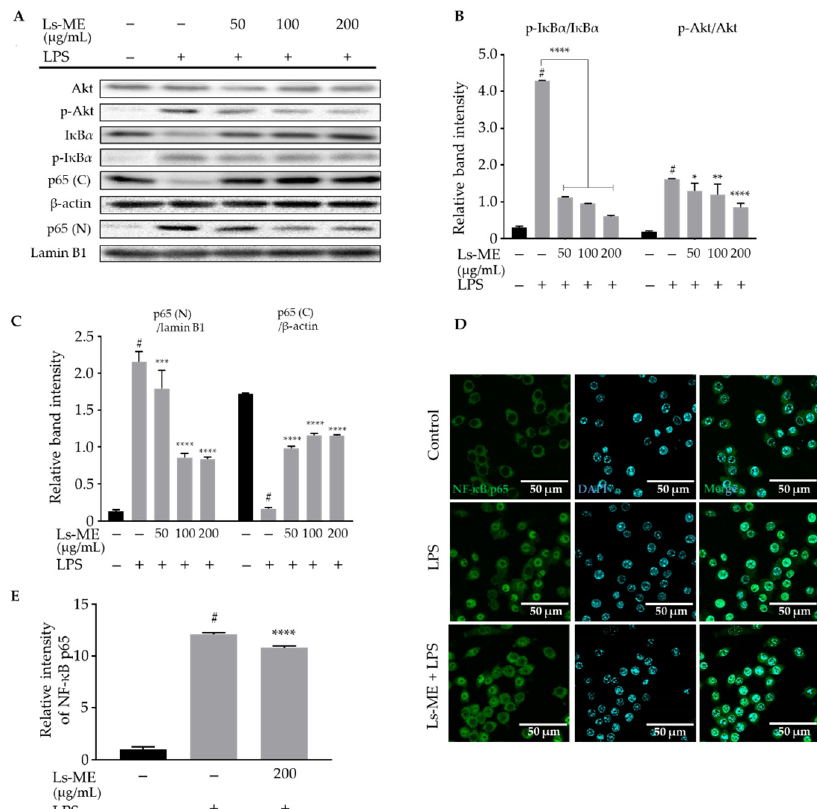
Figure 4. The inhibitory activity of Ls-ME on the activation of NF- κ B / PI3K / Akt pathways in LPS-stimulated RAW 264.7 macrophages. Cells were cultured with serial concentrations of Ls-ME for 24 h, followed by treatment with LPS (1 µ g / mL) for 18 h. Western blot analysis determined the expression of total Akt, I κ B α and phosphorylated p-Akt, p-IkB α ( A ). Cytosol and nuclear fractions were separated in whole-cell lysates to analyze p65 (C, cytosol) and p65 (N, nucleus). The relative band intensity of p-I κ B α to I κ B α and that of p-Akt to Akt was quantified ( B ). The relative band intensity of p65 (C, cytosol) and p65 (N, nucleus) was quantified ( C ). The relative band intensities were analyzed using Image J. Representative images are shown in ( D ) with the green color of Alexa-488. Control, cells incubated alone; LPS, cells incubated with LPS; Ls-ME + LPS, cells incubated with Ls-ME (200 µ g / mL), then treated with LPS. The fluorescent intensities were analyzed by MetaMorph ( n = 35) ( E ). Scale bar indicates 50 µ m. Data of three replicates are represented as mean ± SD. # p < 0.05 is expressed in comparison with cells incubated alone; * p < 0.05; ** p < 0.01; *** p < 0.001; **** p < 0.0001 are expressed in comparison with LPS treatment only.